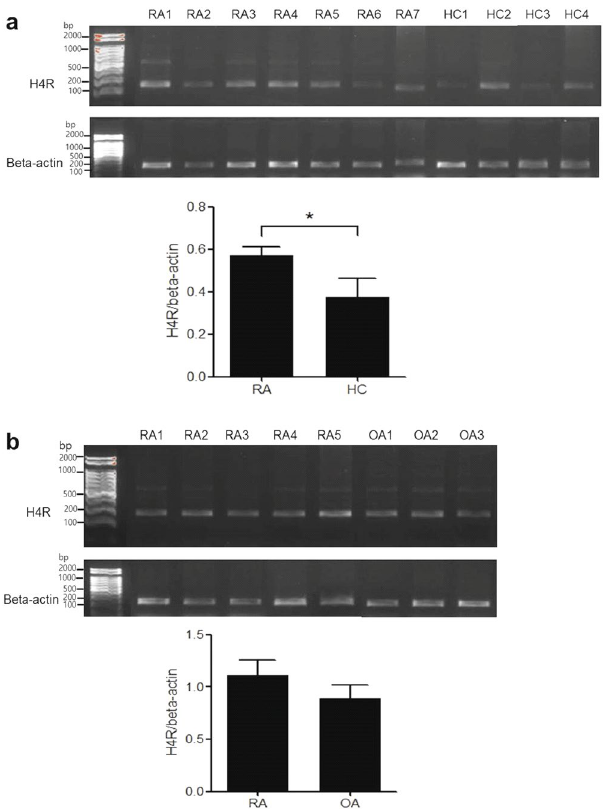
Figure 2. The expression of histamine H4 receptor (H4R) in peripheral blood (PB) and synovial fluid (SF) monocytes of patients with rheumatoid arthritis (RA). ( a ) The basal expression of H4R mRNA in PB CD14 + monocytes from 7 RA patients and 4 healthy controls. ( b ) The basal expression of H4R mRNA in SF monocytes from 5 RA patients and 3 osteoarthritis patients. Data were normalized to beta-actin and reported in relative expression units. The data represent the mean ± SEM of three independent experiments. * P < 0.05. H4R; histamine H4 receptor, RA; rheumatoid arthritis, OA; osteoarthritis, HC; healthy